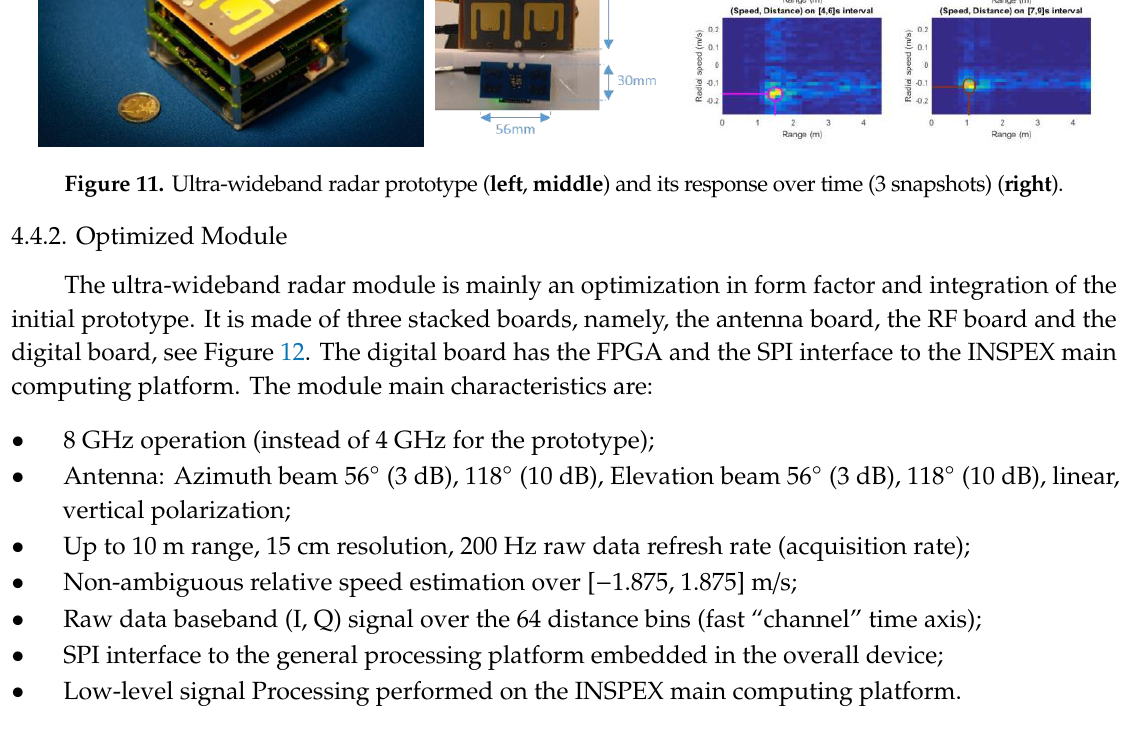
Figure 12. Ultra-wideband radar module. ( a ) Antenna board; ( b ) RF board; ( c ) digital board.